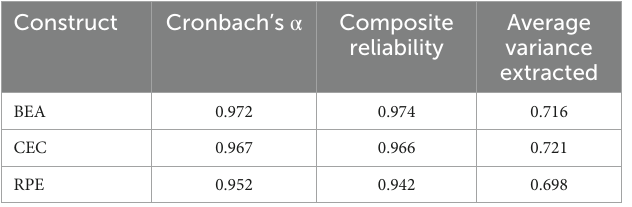
TABLE 2 Reliability and validity tests. TABLE 3 Test of the discriminant validity of potential